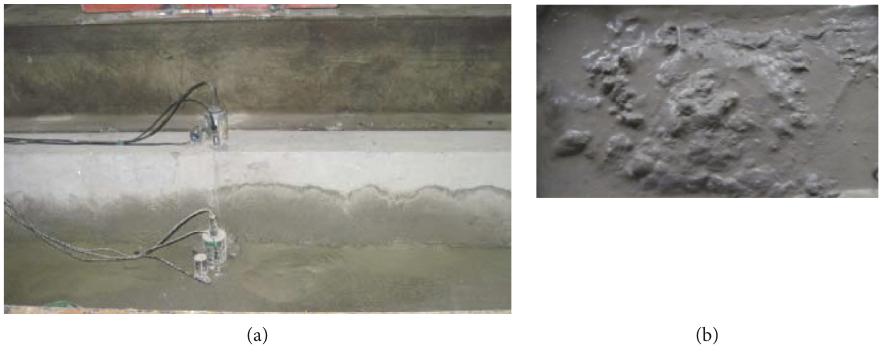
Figure 5: A large amount of slurry squeezed out of the subgrade bed.